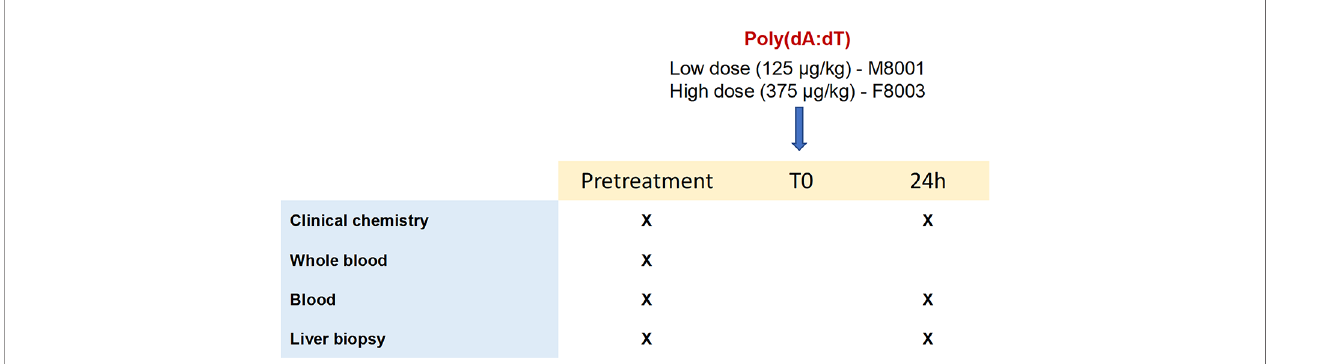
FIGURE 5 | Study design of in vivo poly(dA:dT) administration to woodchucks. Poly(dA:dT) mixed in in vivo- jetPEI-Gal transfection reagent was administered intravenously as a single dose to two WHV-uninfected adult woodchucks. Animal M8001 received a low dose (125 µg/kg), while animal F8003 received a high dose (375 µg/kg) at T0. Cross marks indicate the time of clinical chemistry measurements and sample collection.